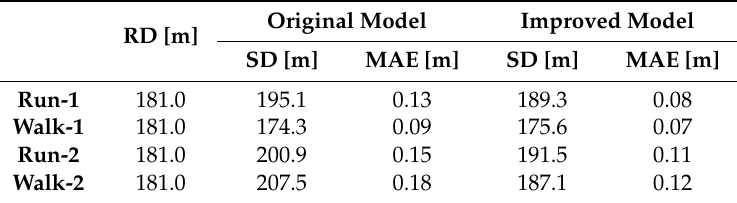
Table 1. Step length analysis of two subjects using different models. RD: realistic distance; SD: solution distance; MAE: mean absolute error.